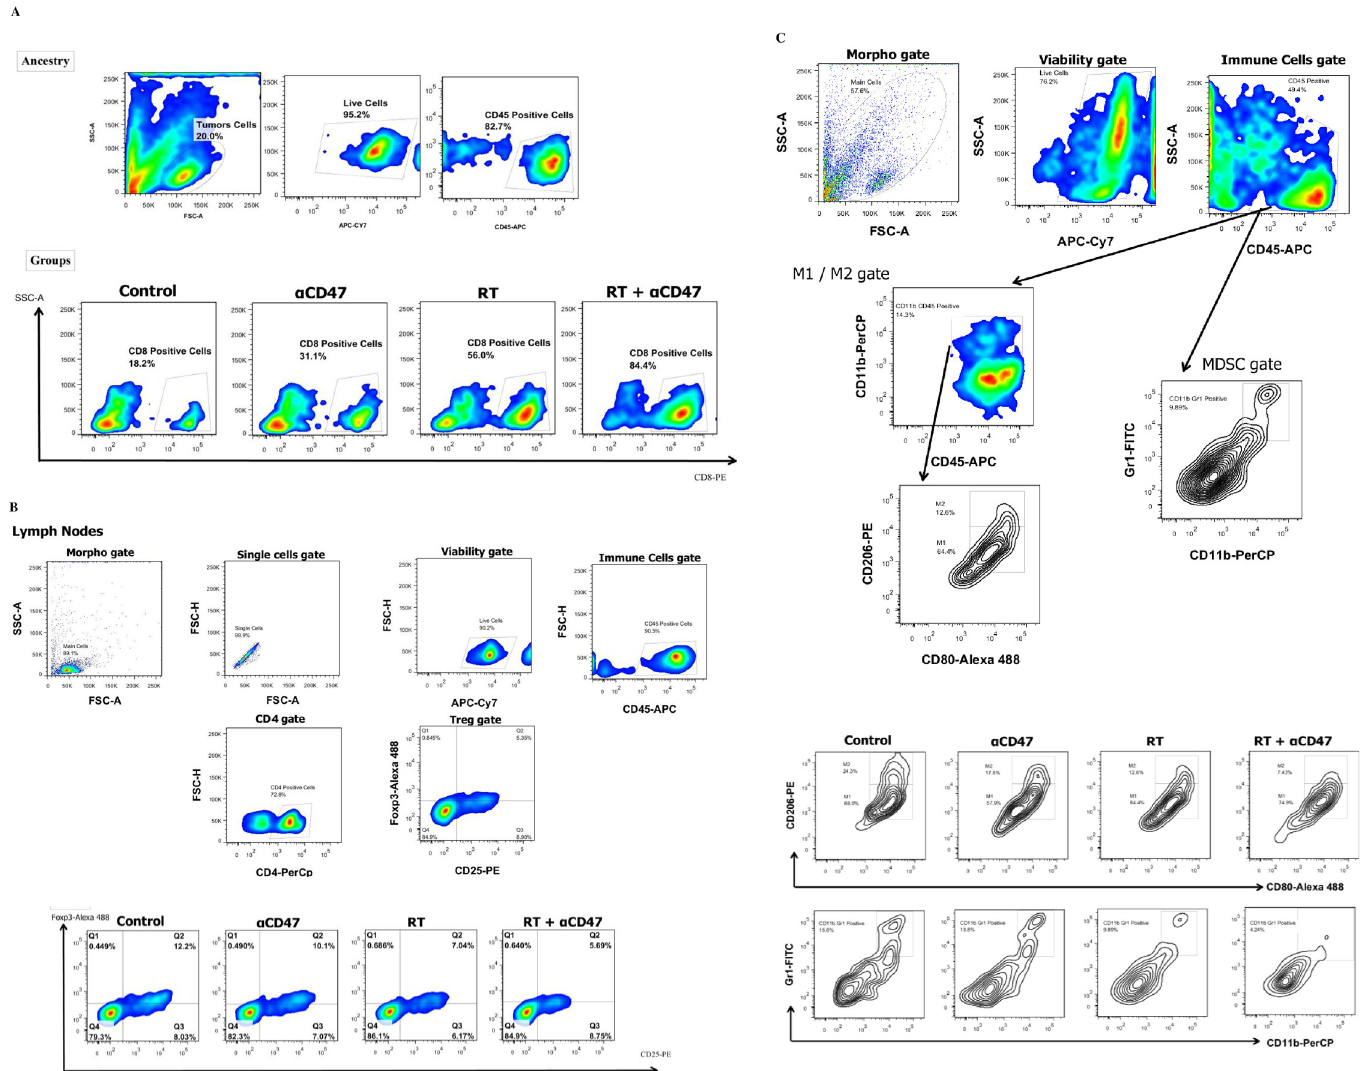
Fig 4. Fluorescence images for identification of CD8+, Treg, M1, M2 macrophages, MDSC cells. Live/CD45 positive populations were gated as immune cells using FlowJo (version 10.6.2). Gating scheme used in TCD8+ phenotyping by flow cytometry in tumor tissue and relevant fluorescence images of these cells in studied groups (A). Gating scheme used in Treg phenotyping by flow cytometry in DLNs and relevant fluorescence images of these cells in studied groups (B). Gating scheme used in M1, M2 macrophages, and MDSC phenotyping by flow cytometry in tumor tissue and relevant fluorescence images of these cells in studied groups